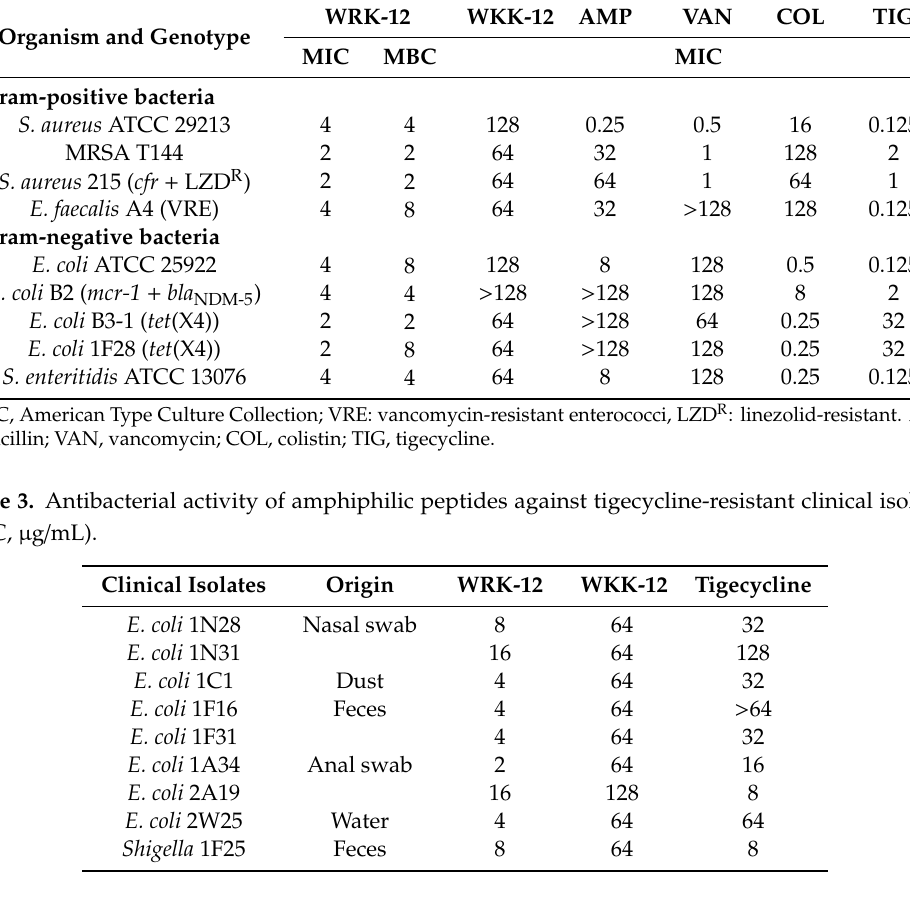
Table 2. Antibacterial spectrum of two amphiphilic peptides against a panel of pathogenic bacteria (MIC or MBC, µ g / mL).